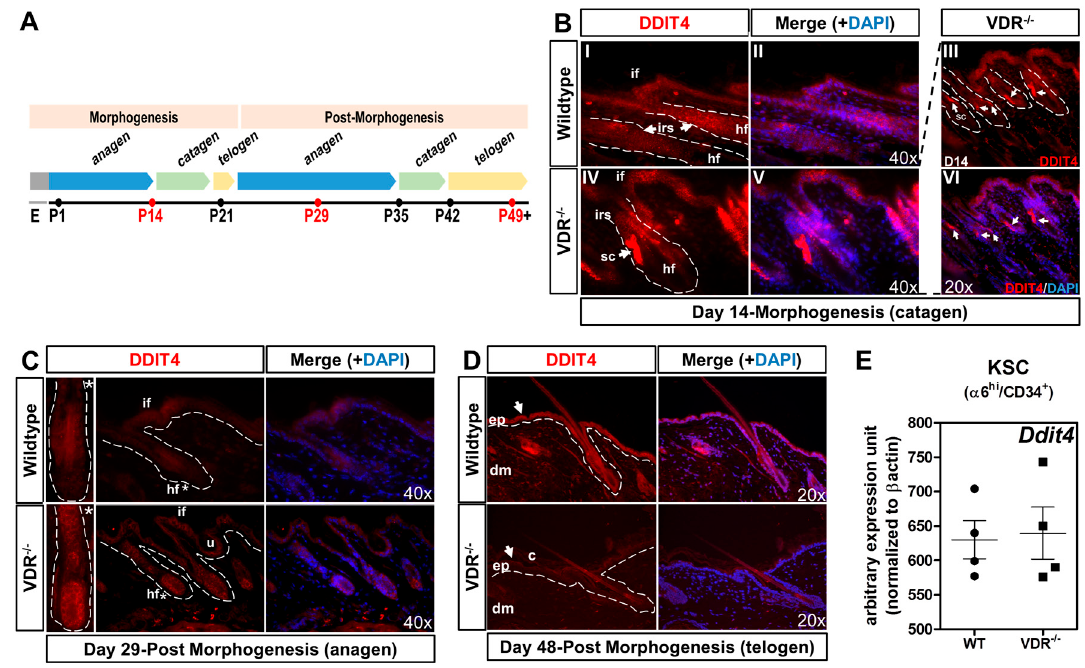
Figure 4. Ddit4 α -positive stress compartments present in VDR − / − morphogenic hair follicles (column 2). ( A ) Chart depicting the morphogenic and post-morphogenic stages of the hair cycle up to